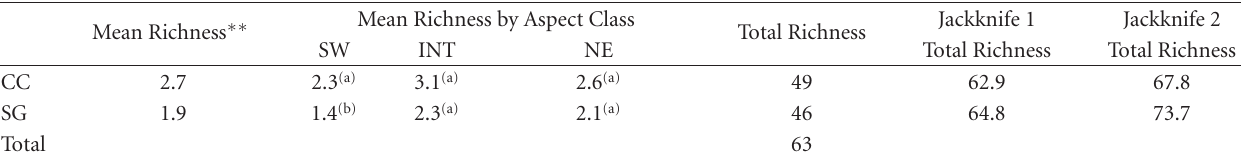
Table 2: Mean, total, and Jackknife estimated species richness in 192 seed bank samples collected from six revegetating clearcut (CC; ∼ 7 years) and six second-growth (SG; ∼ 125 years) forest stands at WWRS. Double asterisk ( ∗∗ ) indicates significant di ff erence in CC and SG richness ( P < . 01). Letters indicate significant di ff erence among CC/SG topographic aspect classes ( P < .